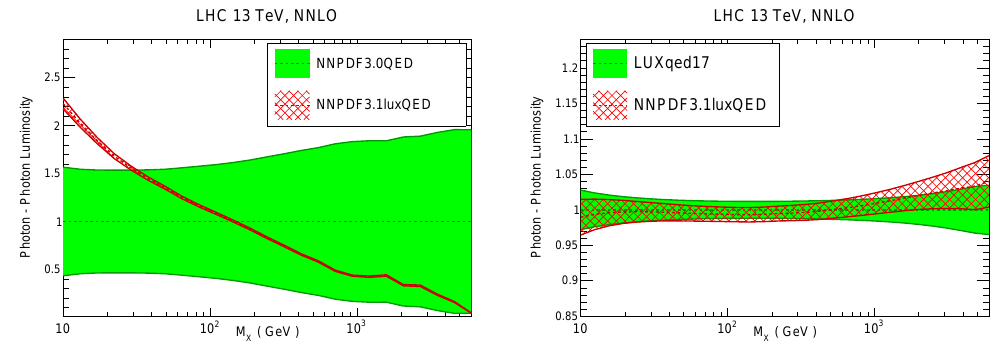
Figure 3.7: Comparison of the γγ PDF luminosities between NNPDF3.1luxQED and NNPDF3.0QED (left) and LUXqed17 (right plot) as a function of M that the y axis range is different in the both plots.